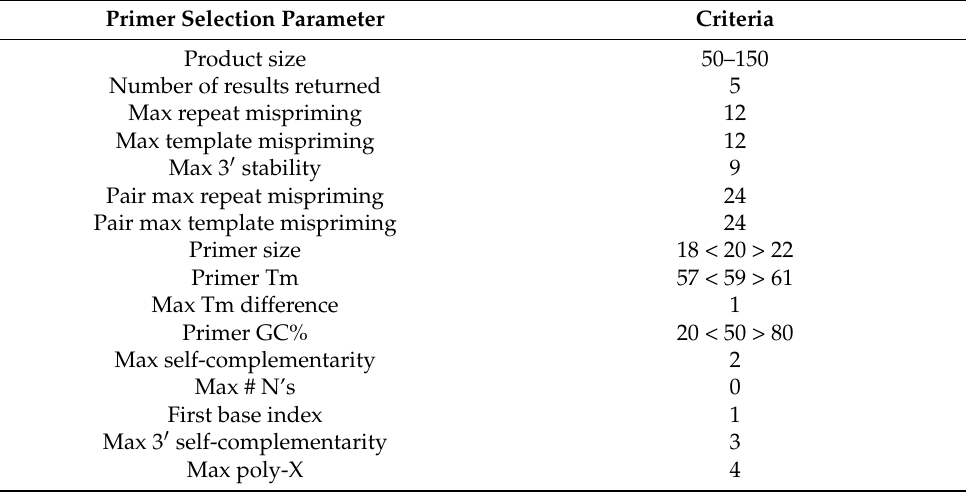
Table 1. Selection criteria for primers used to amplify transcripts for quantitative real-time poly- merase chain